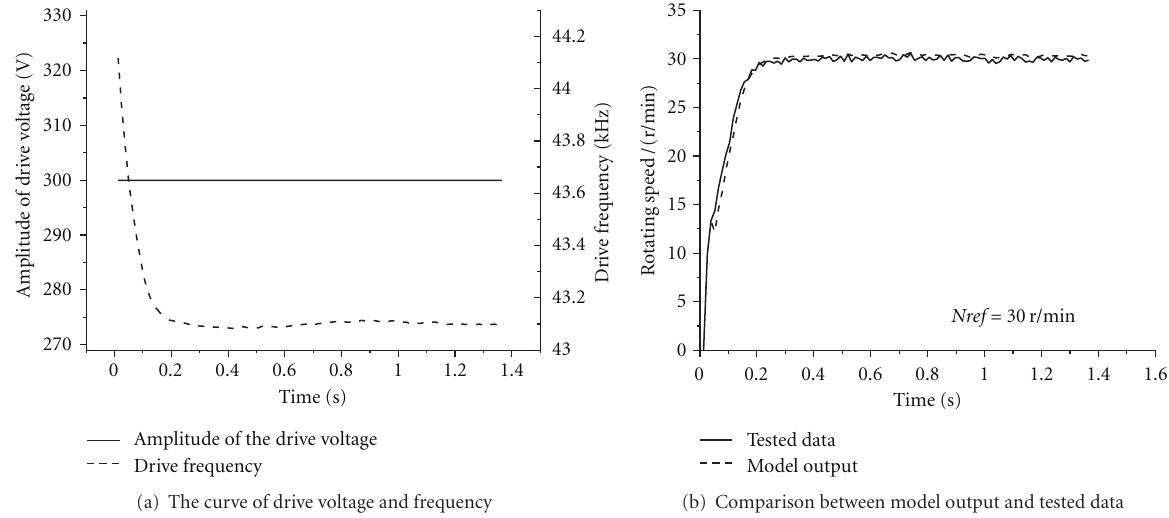
(b) Comparison between model output and tested data Figure 13: Step response comparison between model output and tested data ( Nre f = 30r/min, Ure f = 300V, load torque =